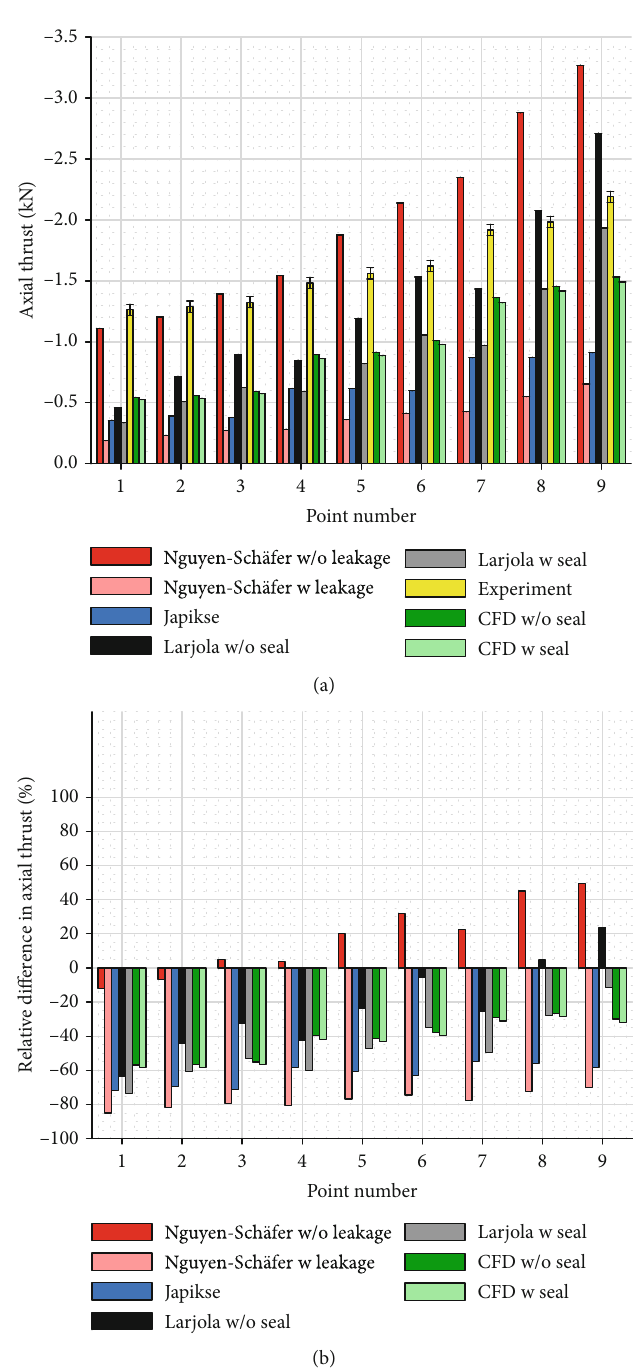
Figure 7: (a) The axial thrust predicted with three methods, numerically modeled and measured. (b) Relative di ff erence between the predicted and measured axial